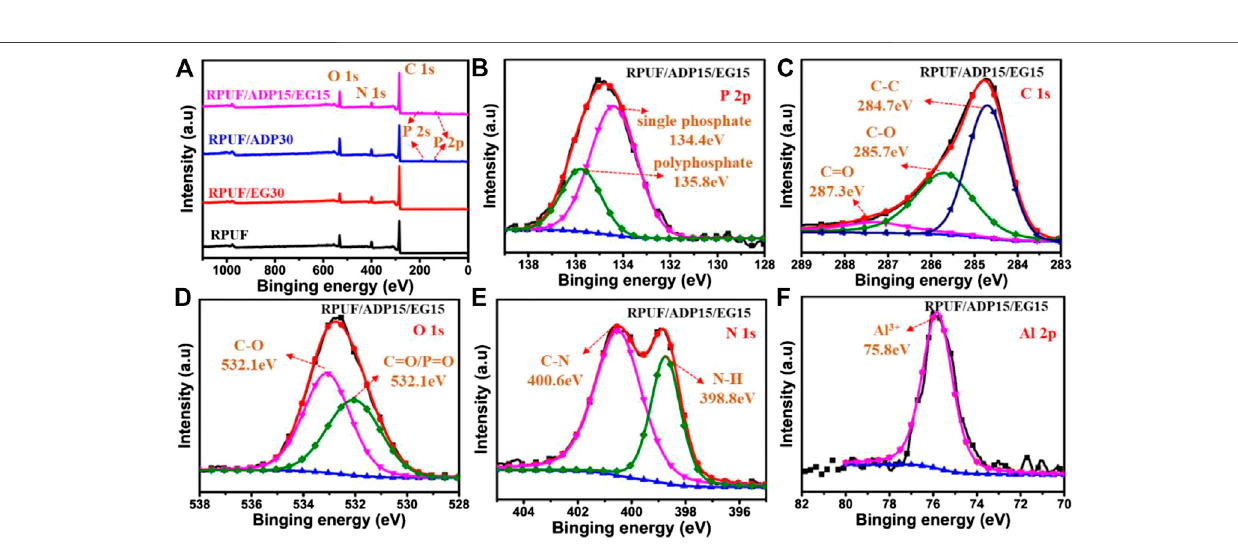
Frontiers in Materials |